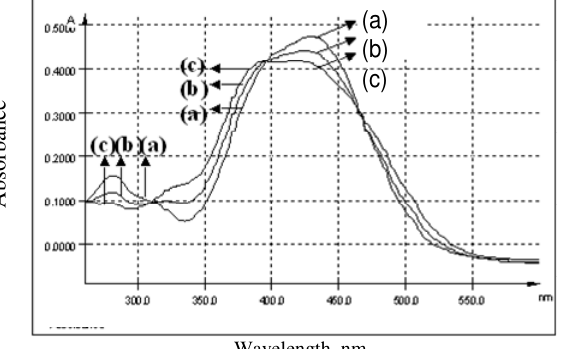
Figure 1 . UV-Vis spactra of 1 at pH (a) 2.56, (b) 4.02 and (c)